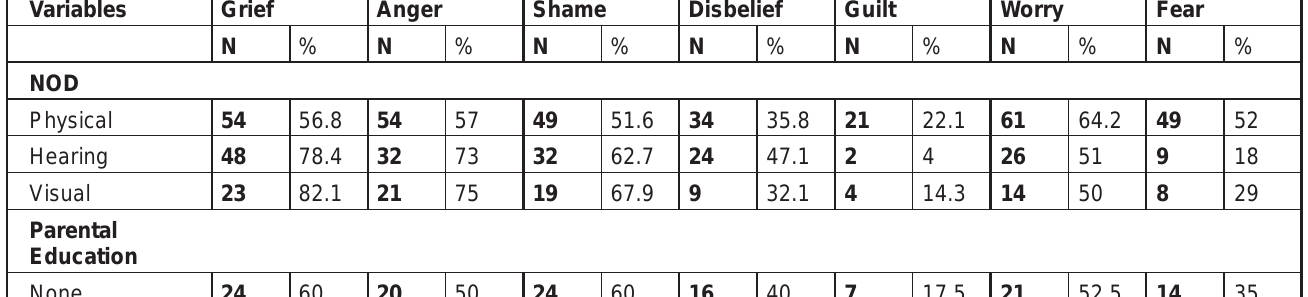
Table 1: Parents emotions on discovery of child’s disability Variables Grief Anger